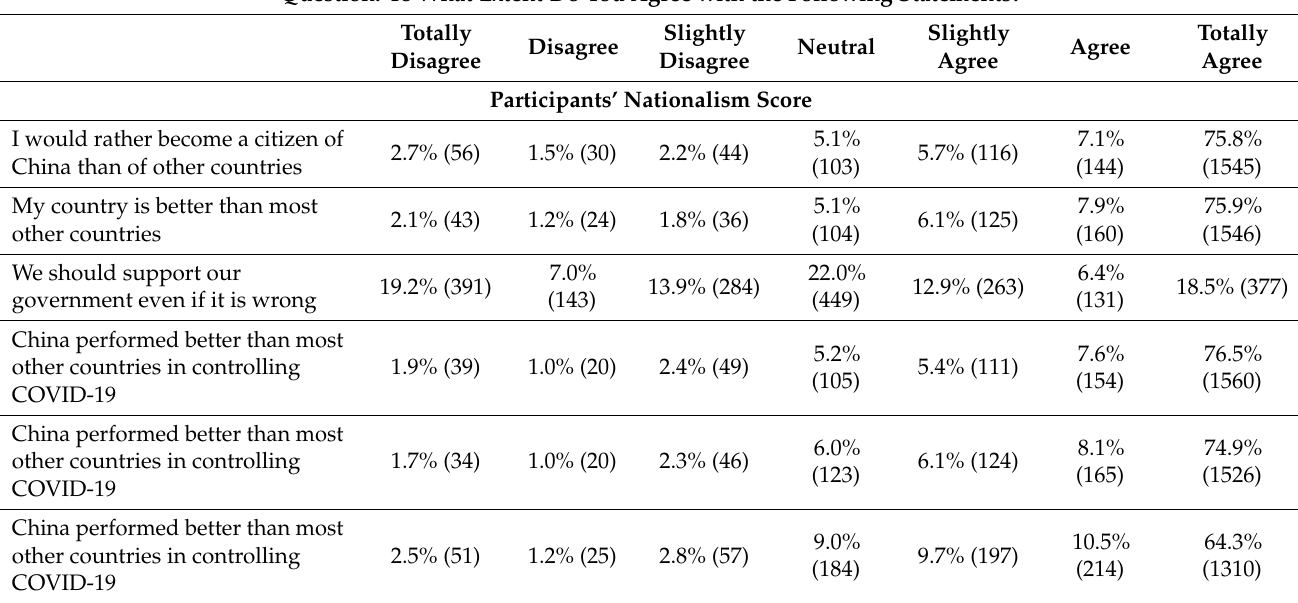
Table 7. Participants’ nationalism score ( n =